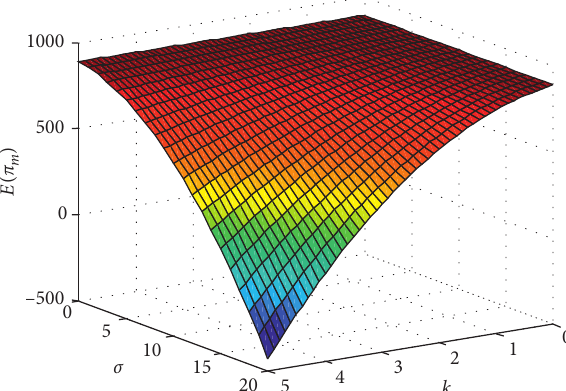
Figure 5: The trend of the manufacturer’s profits under the re- tailer-dominant structure.